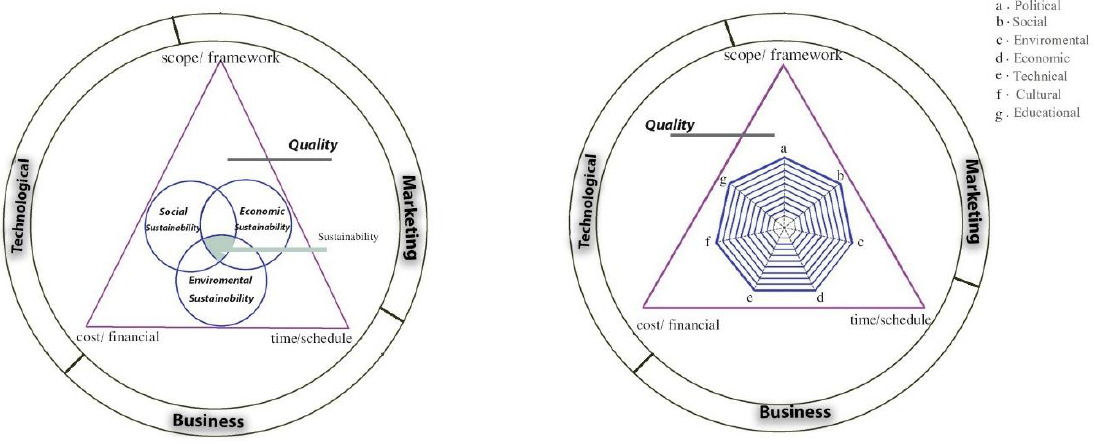
Figure 9. DR-ISPM Figure 9. DR-ISPM model.